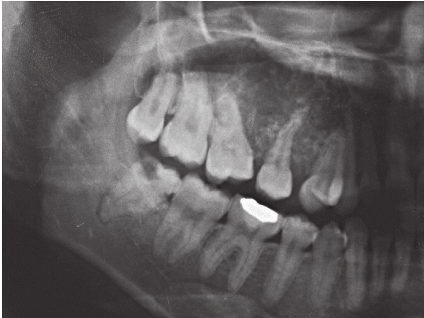
Figure 1: Maxillary odontogenic myxoma in a 26-year-old woman (Patient 3). Cropped panoramic image shows ill-defined multi- locular radiolucency located in the dentate area from maxillary right first premolar to the third